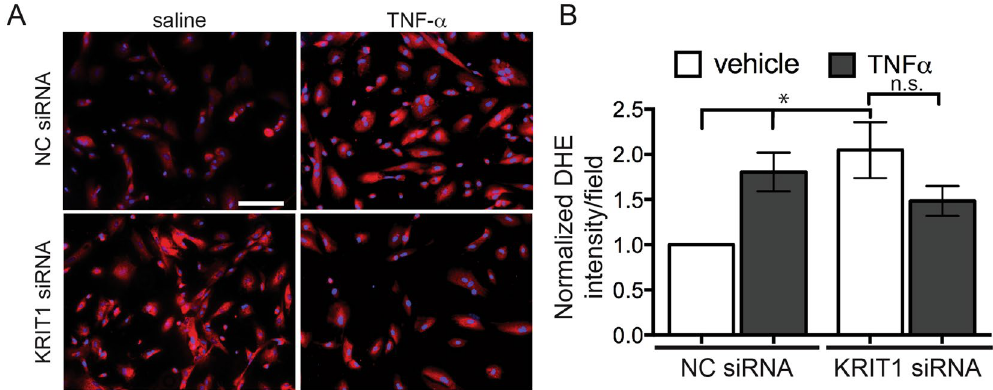
Figure 2. Loss of KRIT1 blunts TNF- α -induced increased ROS. ( A ) DHE fluorescence in negative control (NC) siRNA or anti-KRIT1 siRNA transfected HPAEC treated + / − 25 ng/ml TNF- α . Images are representative of n = 4 independent experiments. ( B ) Average DHE intensity per field of view + / − SEM, normalized to NC siRNA + vehicle, n = 16. p = 0.0137 by ANOVA; * p < 0.05 by Tukey’s post-hoc test, n.s., not